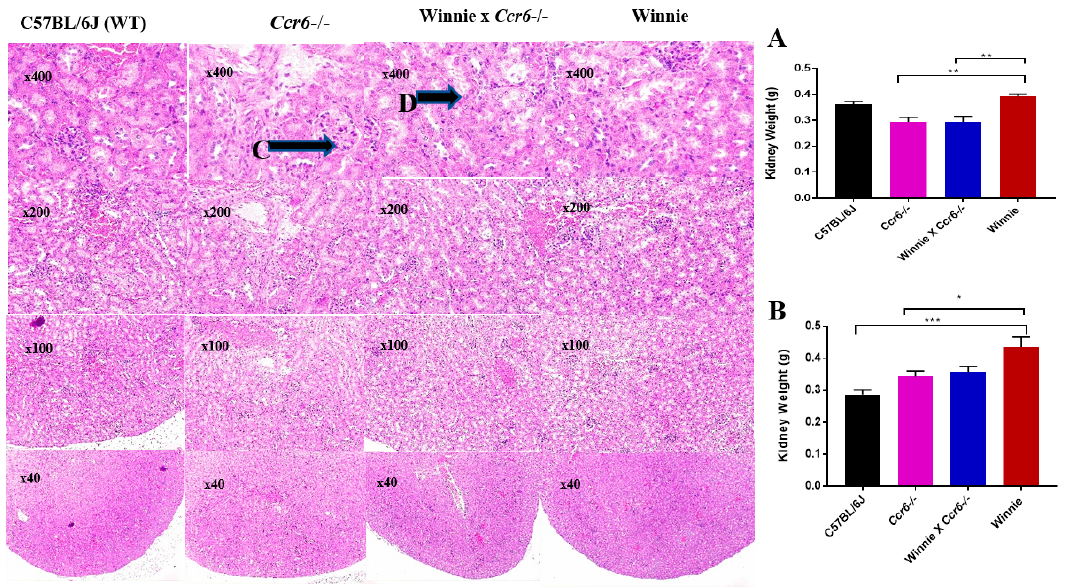
Figure 6. Representative images of H&E in kidney histology in the four genotypes at 16–22 weeks of age. Arrows indicate ( A ) comparison of kidney weight at 8 weeks of age ( B ) comparison of kidney